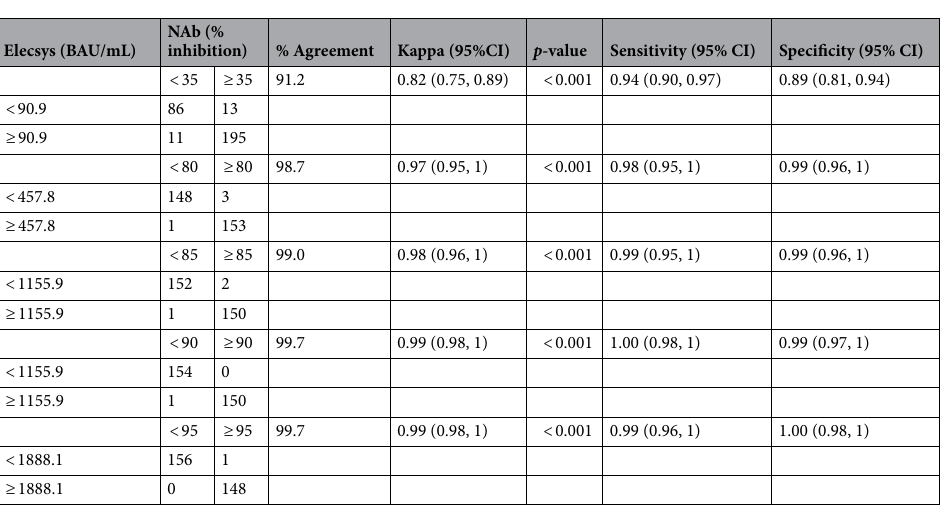
Table 2. The optimal cut-off value of the Elecsys anti-SARS CoV-2 immunoassay using the SARS-CoV-2 NeutraLISA as a reference standard.